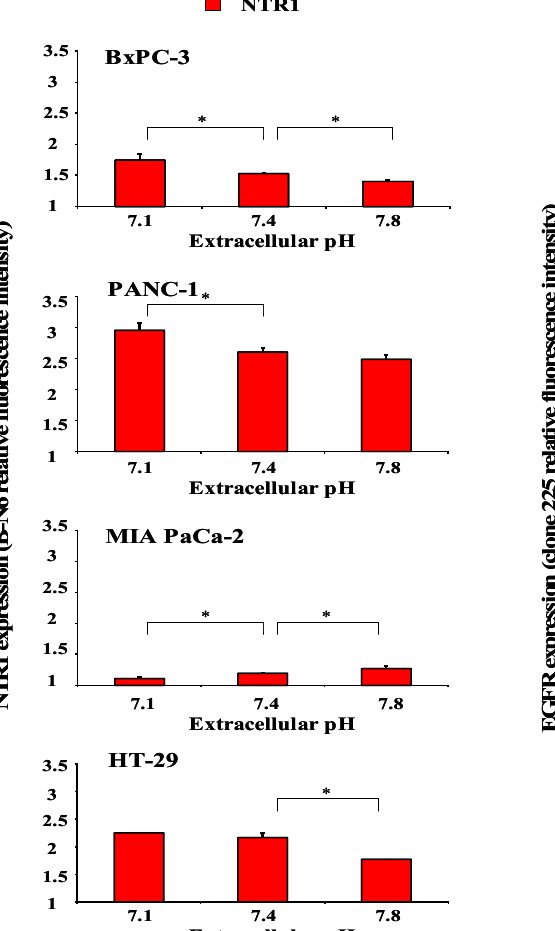
Figure 4. Dependence of NTR1 (left) and EGFR (right) expression in BxPC-3, PANC-1 , determined by flow cytometry. Data are presented as mean and MIA PaCa-2 cells on pH e ± SD of duplicate measurements (differences to physiological pH 7.4: * p < 0.05). NTR1